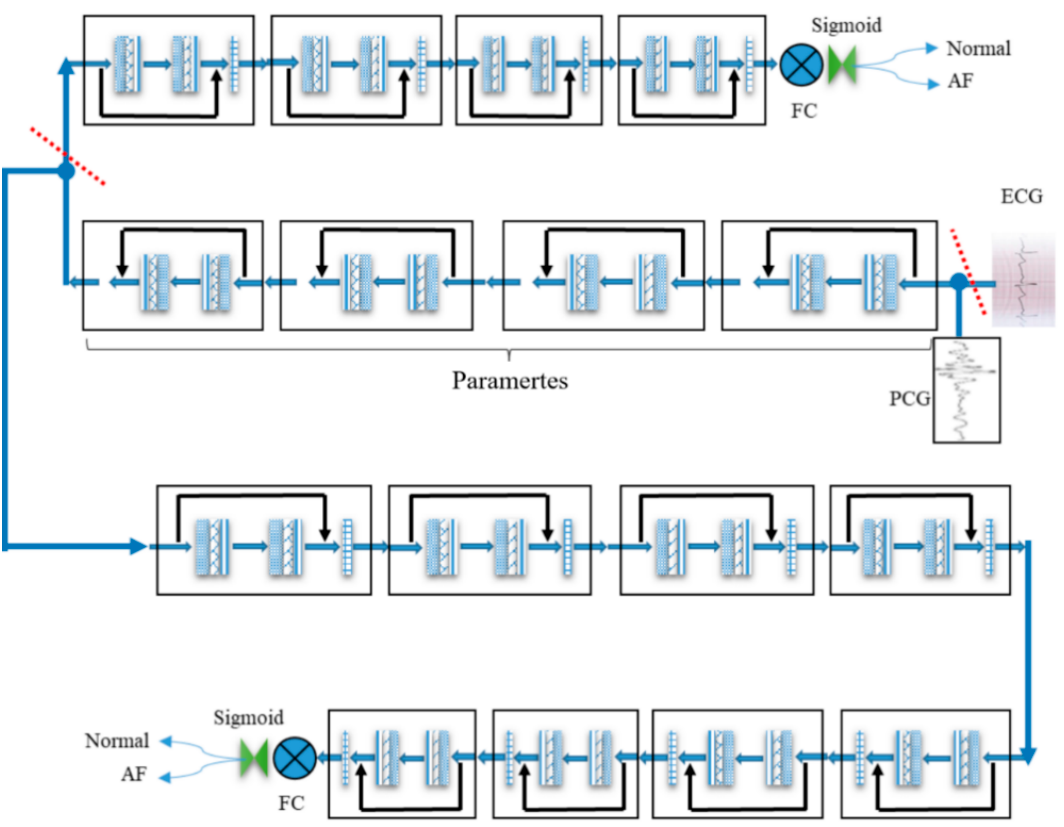
Figure 3. The transfer learning of large kernel network LKNet processes from ECG to PCG.